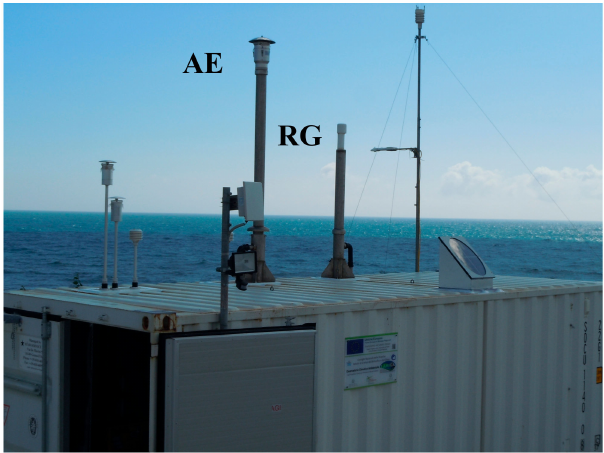
Figure 4. External view of the WMO/GAW regional station at Capo Granitola (CGR): AE and RG sampling systems are